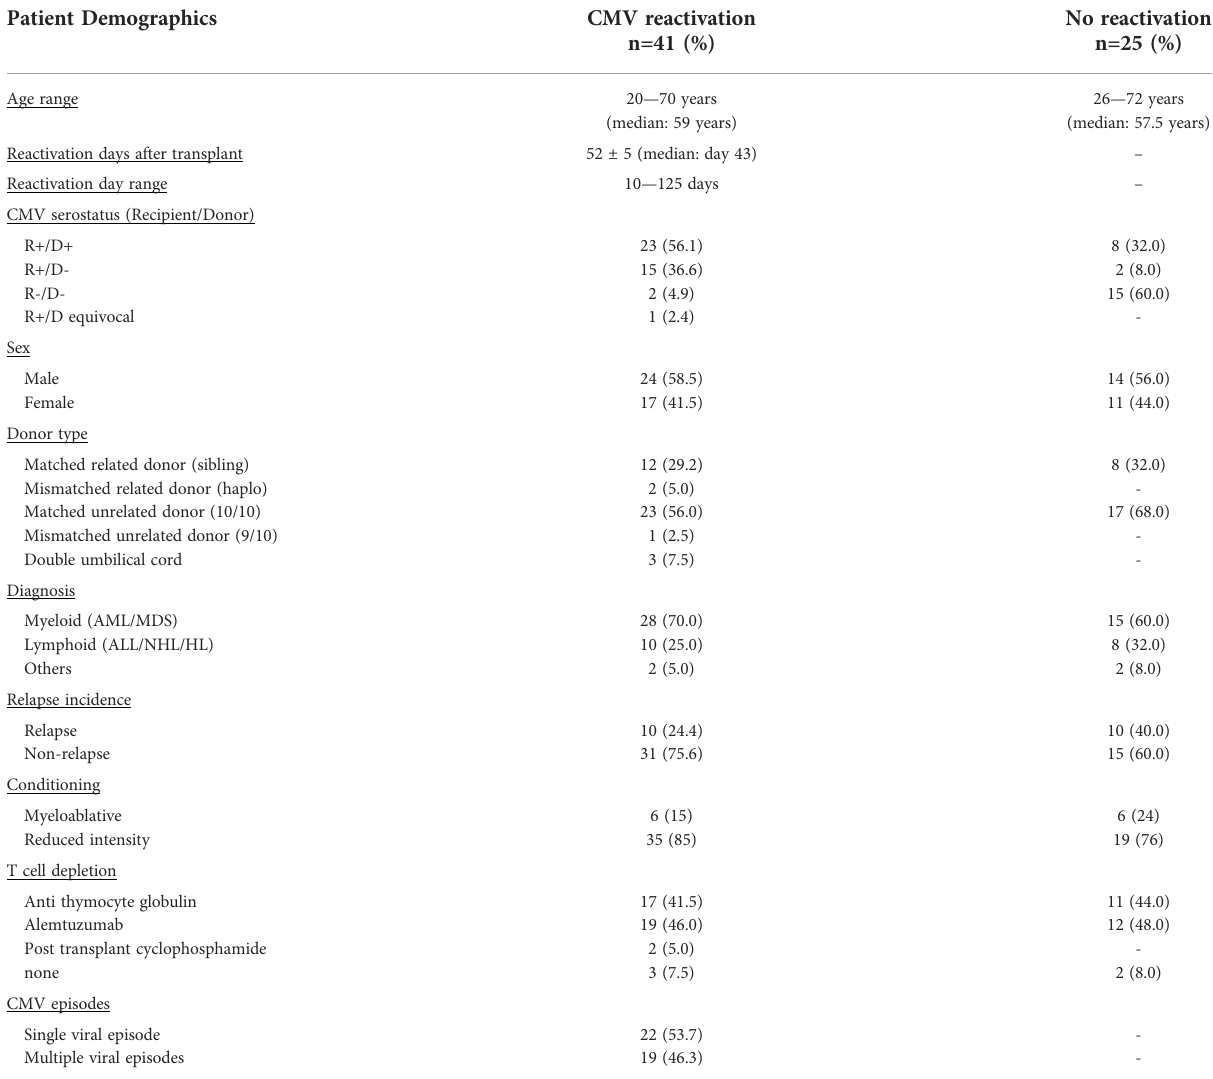
TABLE 1 The demographic characteristics of patients in this